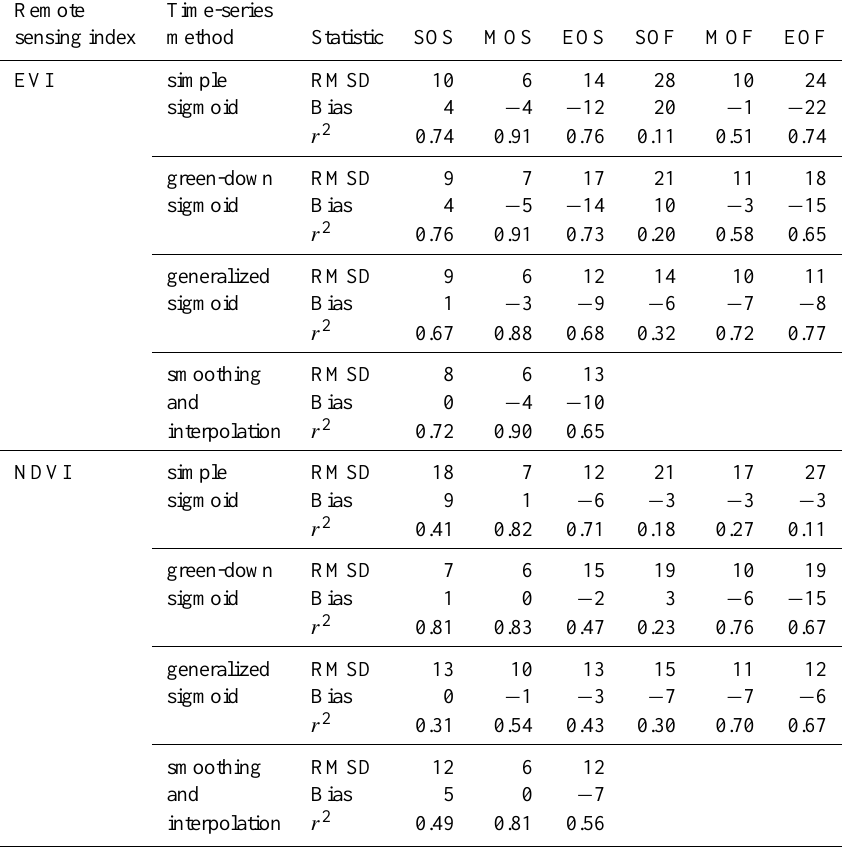
Table 4. Statistics comparing remote-sensing-derived to greenness-derived near-surface phenology. Statistics are computed as in Table 3. The time-series method indicated in the table was used for both near-surface and remote sensing date estimates. Bias is calculated relative to near-surface estimates, so a negative bias indicates that the corresponding remote sensing estimate is later. 81 site years of data were used in this